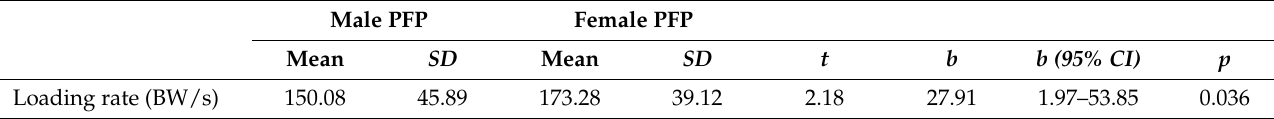
Table 11. Joint loading and temporal indices in male and female PFP